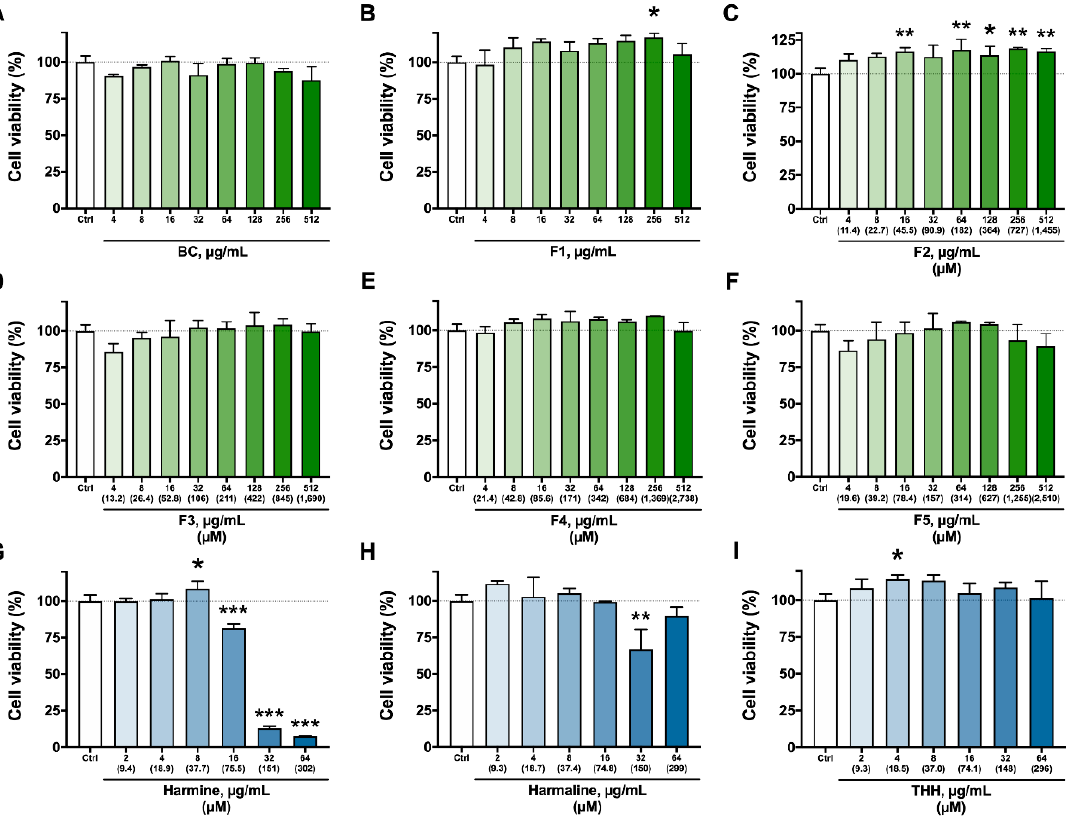
Figure 3. Viability of BV-2 cells treated at different concentrations for 2 h with Banisteriopsis caapi extract (BC, ( A )), the isolated fractions F1 to F5 ( B – F ), and β -carbolines ( G – I ). Values are presented as mean ± SEM ( n = 3, except for control, n = 6). * p < 0.05, ** p < 0.01, *** p < 0.001 compared to cells with no treatment (control).